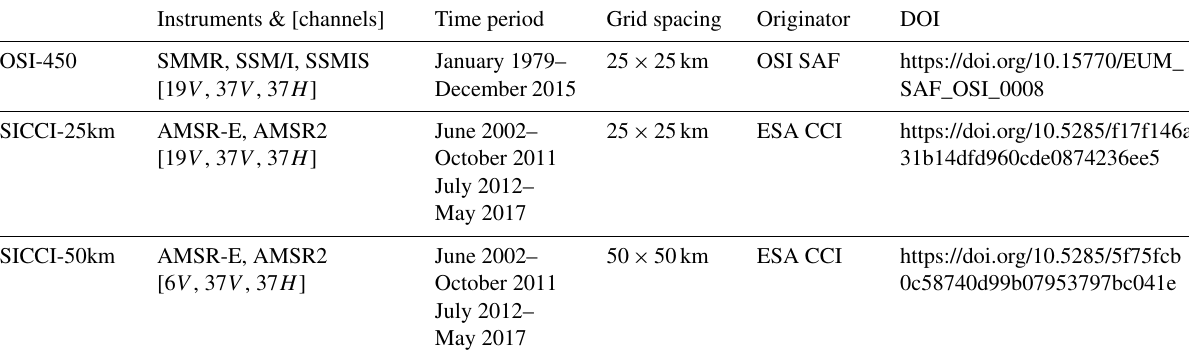
Table 1. Summary of the three SIC CDRs presented in this paper. The values entered in the table are all described in the course of the paper. Instruments &